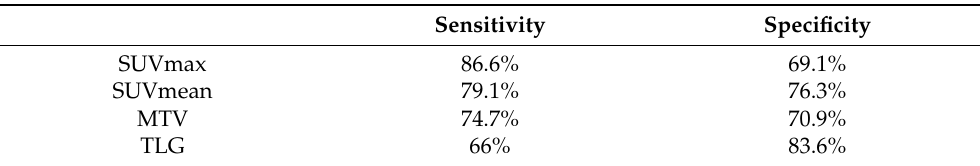
Figure 2. Receiver Operating Characteristic analysis and the related Area Under the Curve for SUVmax ( a ), SUVmean ( b ) MTV ( c ) and TLG ( d ). Table 5. Sensitivity and specificity of maximum standardized uptake value (SUVmax), mean standardized uptake value (SUVmean), metabolic tumor volume (MTV) and total lesion glycolysis (TLG) for optimal cut-offs.